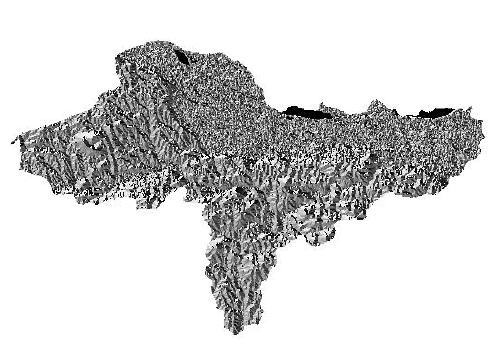
Figure 5 . Suitable solar panels areas for slope 27°-31°